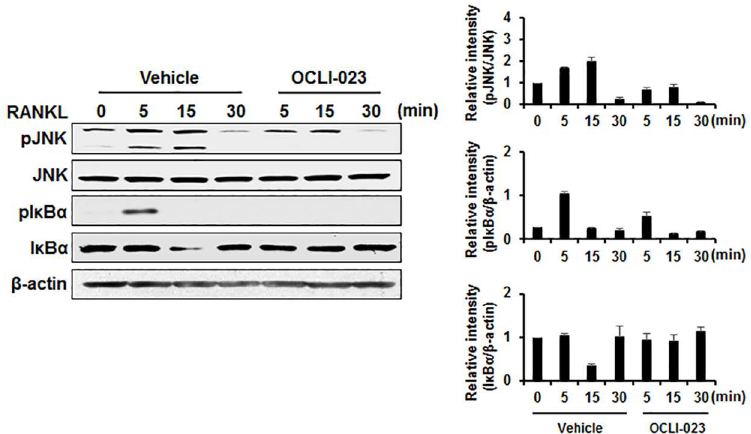
Fig 3. Effects of OCLI-023 on RANKL-stimulated signaling. BMMs were serum-starved for 5 h, then pretreatedwith OCLI-023 (5 μ M) or vehicle for 1 h before RANKL (50 ng/mL) stimulationfor the indicated times. Phosphorylationof JNK and I κ B α was assessed by western blot. JNK or β -actin was used as the